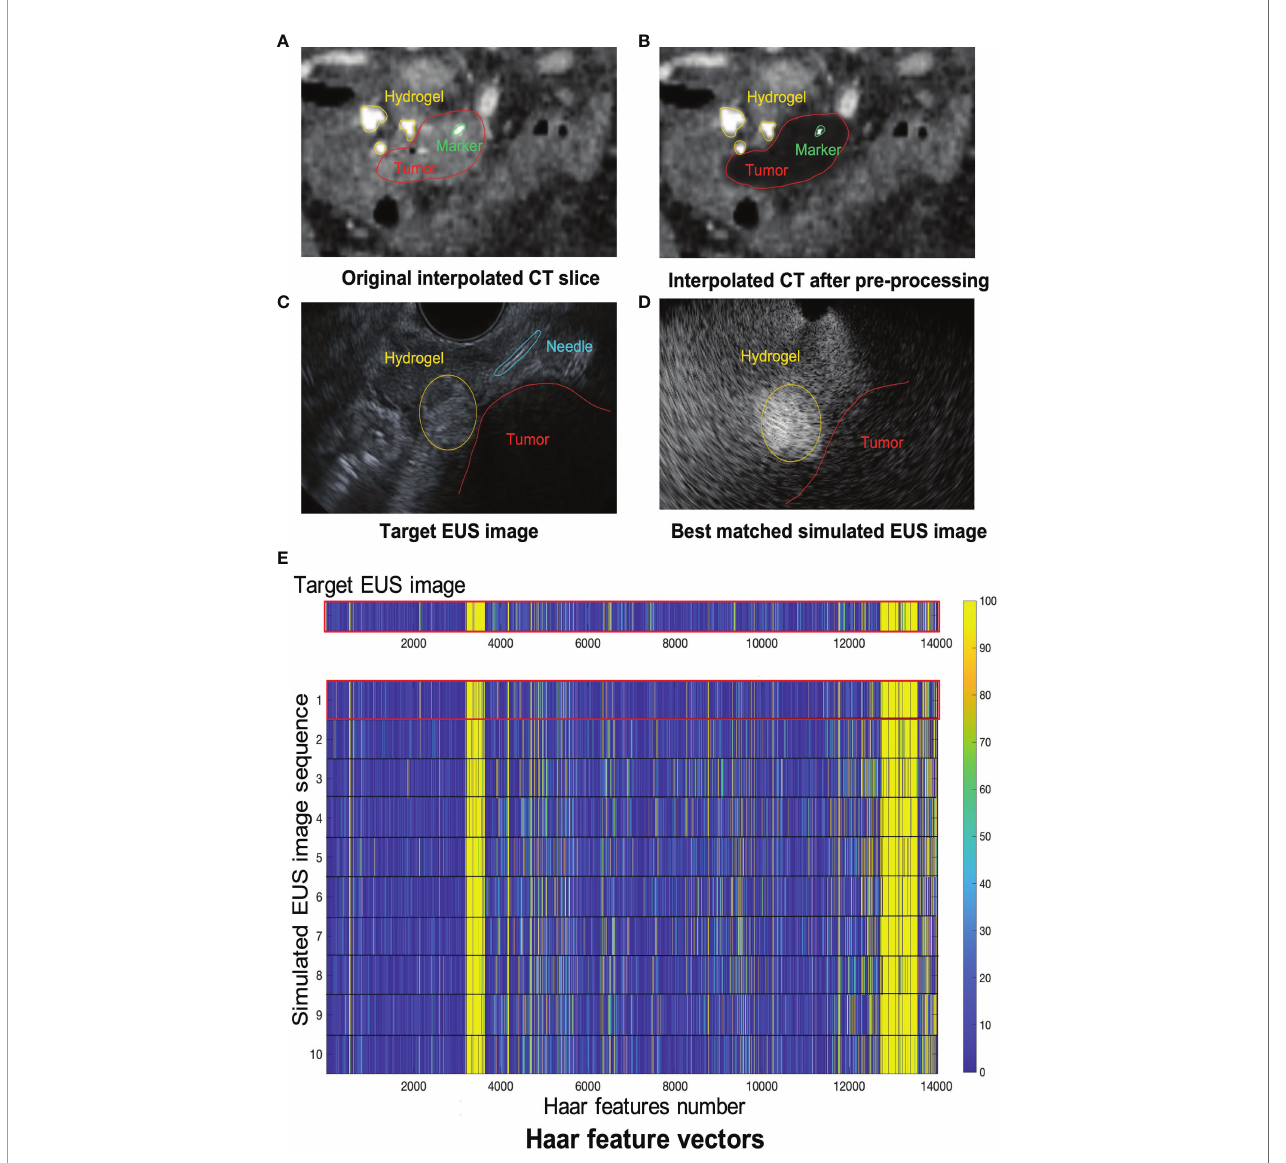
FIGURE 8 | (A, B) show one example of ICT and pre-processing ICT, respectively. Red, yellow and green contours represented tumor, hydrogel, and tumor marker, respectively. The target EUS image and the best matched simulated EUS image are shown in (C, D) , respectively. Red, yellow, and blue contours represented tumor, hydrogel, and injected needle, respectively. (E) shows the Haar feature vector comparison between the target EUS image and all 10 simulated EUS images. The Haar feature vector in the red frame is calculated based on the best matched simulated EUS